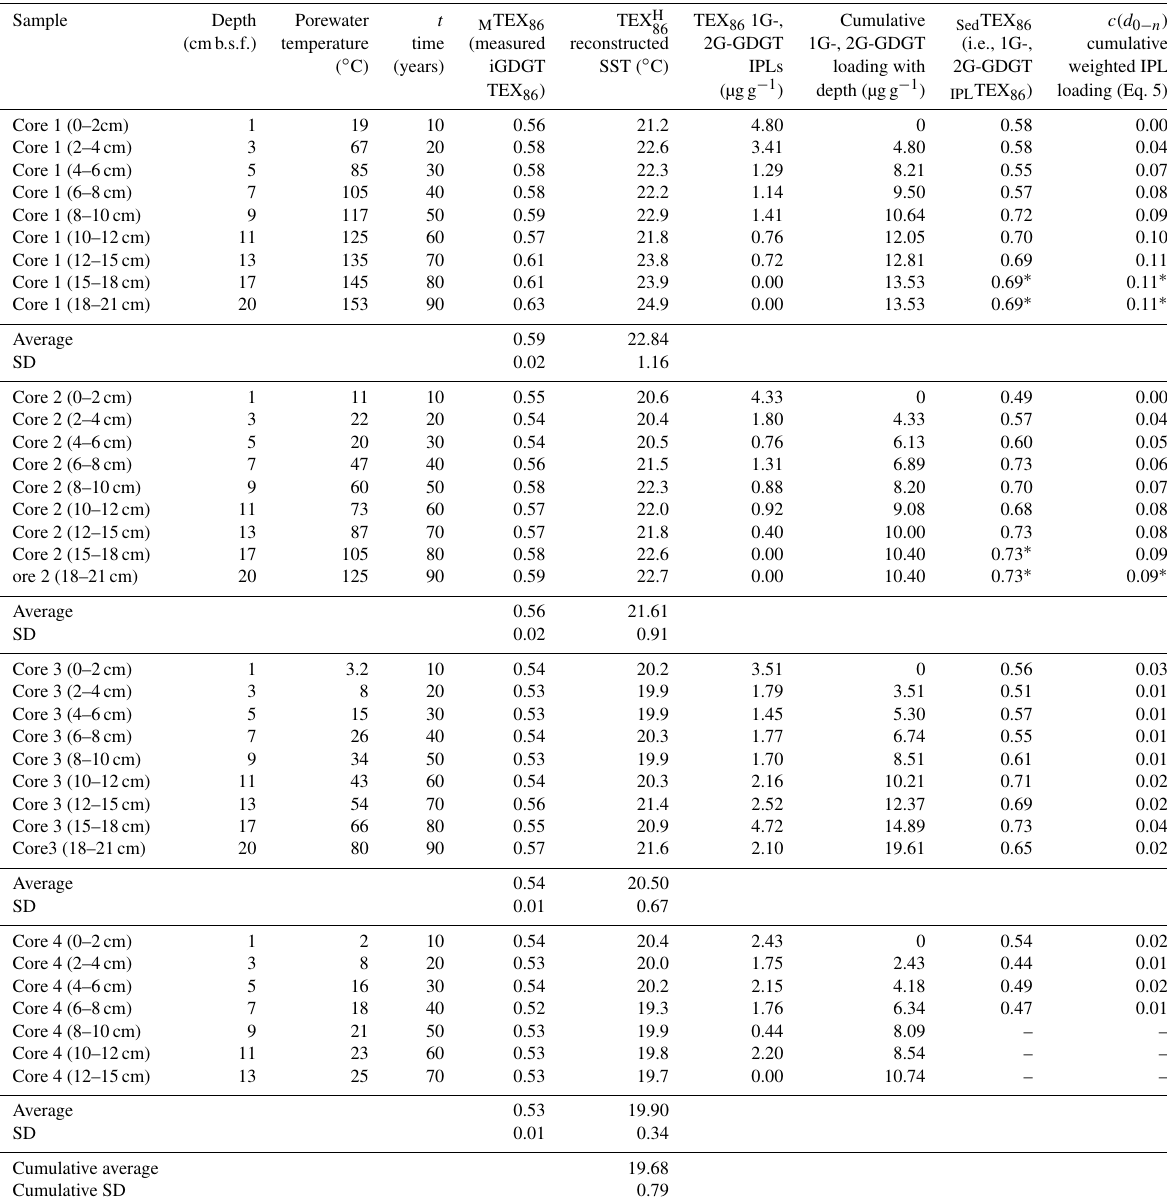
Table 2. Reconstructed sea-surface